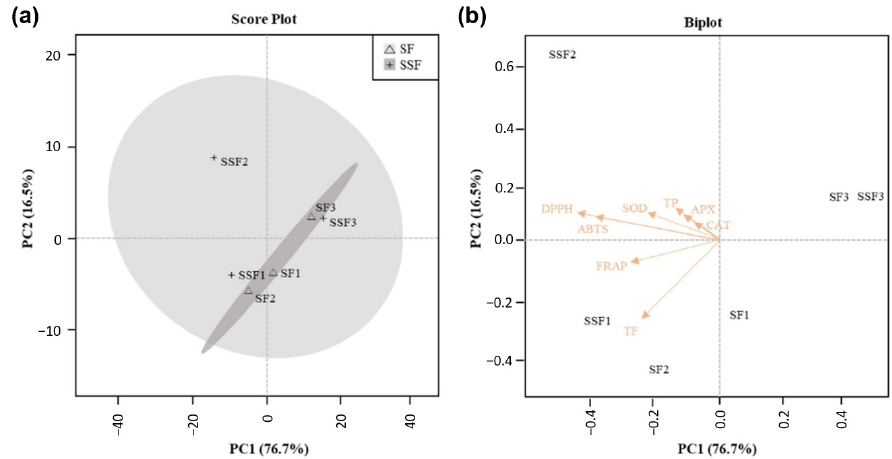
Figure 3. Score plot ( a ) and biplot ( b ) for PCA analysis of the different solvent extracts of Sargassum fusiforme for antioxidant determinants. SF1: S. fusiforme ethanol extract, SF2: S. fusiforme methanol extract, SF3: S. fusiforme water extract, SSF1: Steamed S. fusiforme ethanol extract, SSF2: Steamed S. fusiforme methanol extract, SSF3: Steamed S. fusiforme water extract, TP: Total polyphenol content, TF: Total flavonoid content.